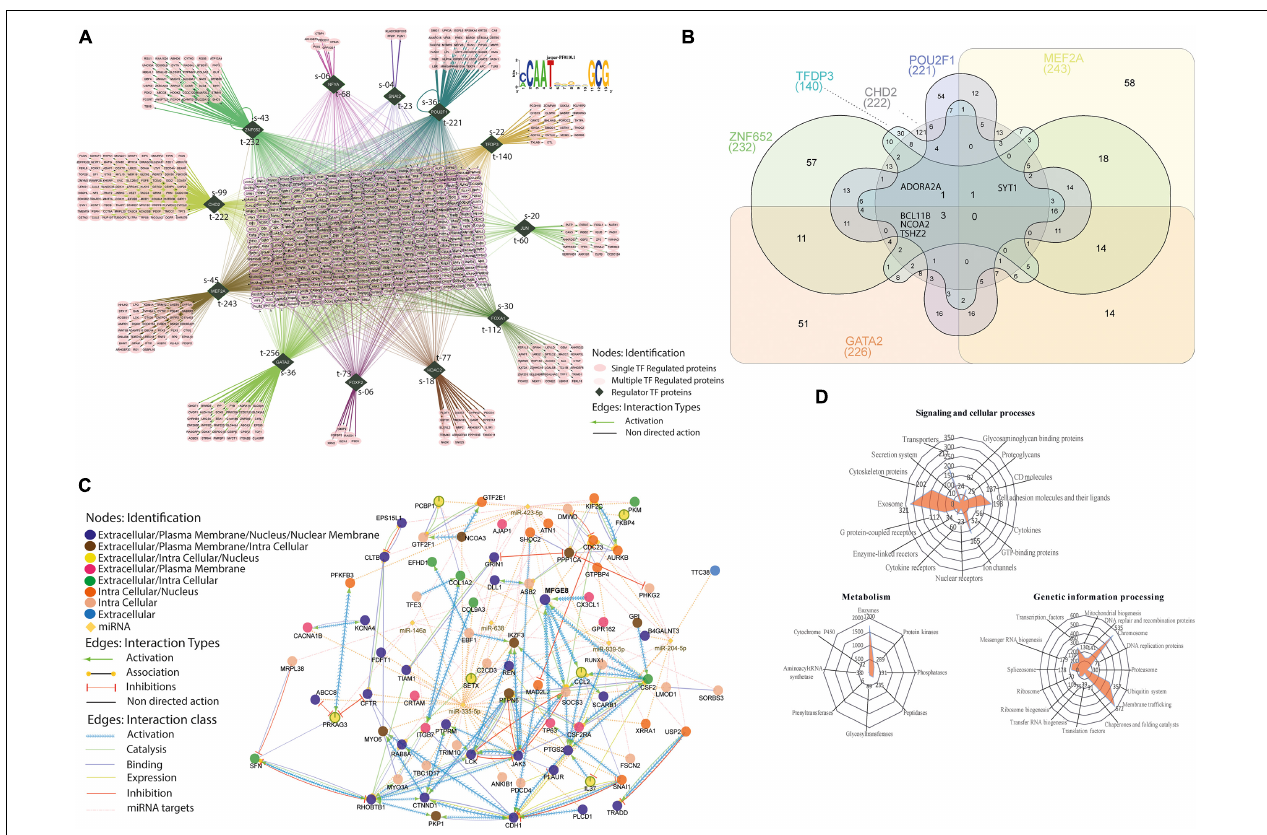
FIGURE 7 | Transcription factor(s) associated with regulome. (A) All the identified significantly ( p < 0.001) differentially expressed proteins with 1.5-fold change up and down were used, n = 938 proteins for the identification of associated TFs involved in the cell cycle regulation. The dark green rhombus shape nodes show the TFs, S defines the number of singly associated protein partners, t defines the total number of protein partners associated with individual TFs. Interactions are color-coded and detailed described in the bottom right downside. JASPAR based position-specific scoring matrices predicted the regulatory control sequences that represent the binding specificity of TFs. (B) Venn Diagram. For the comparison of six TFs and their identified number of target proteins. It determined the common targets proteins associated with six TFs (GATA2, ZNF652, TFDP3, CHD2, POU2F1, and MEF2A), the total of targets in individual TF is reported below in round bracket. Inside the Venn diagram, the number reports the common proteins. (C) A directed network of MFGE8–miRNA interactome. The in silico based network analysis of directly interacted miRNAs and their associated proteins partners, which was also identified as significantly ( p < 0.001) differentially expressed in MFGE8 KD proteome. See also Supplementary Figure 5 for detailed analysis. (D) Radar plot. The identified proteins were mapped against the KEGG database for the determination of redundant involvement in molecular signaling and cellular processes, metabolic process, and genetic information processing. All the mapped proteins in the specific process were plotted in three different radar plots and indicated with the number of proteins